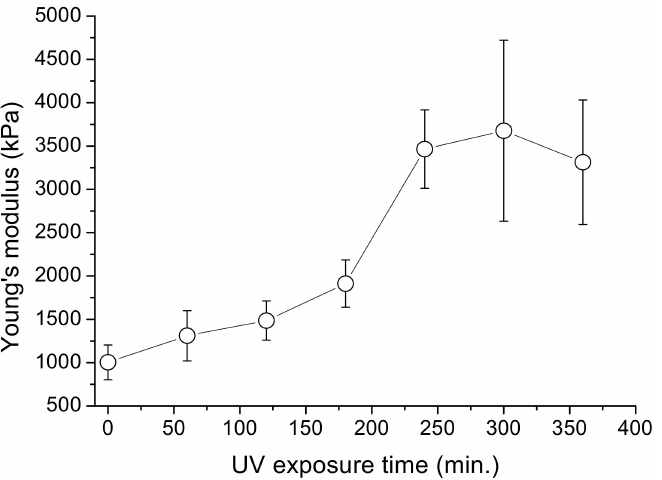
Figure 10. Variation of the Young’s modulus as a function of UV post-cure exposure time: Young’s modulus increases from ~1000 to ~3700 kPa within the first 300 min of post-fabrication UV exposure. The circles represent data averaged from three specimens and the error bars indicate the standard deviation of